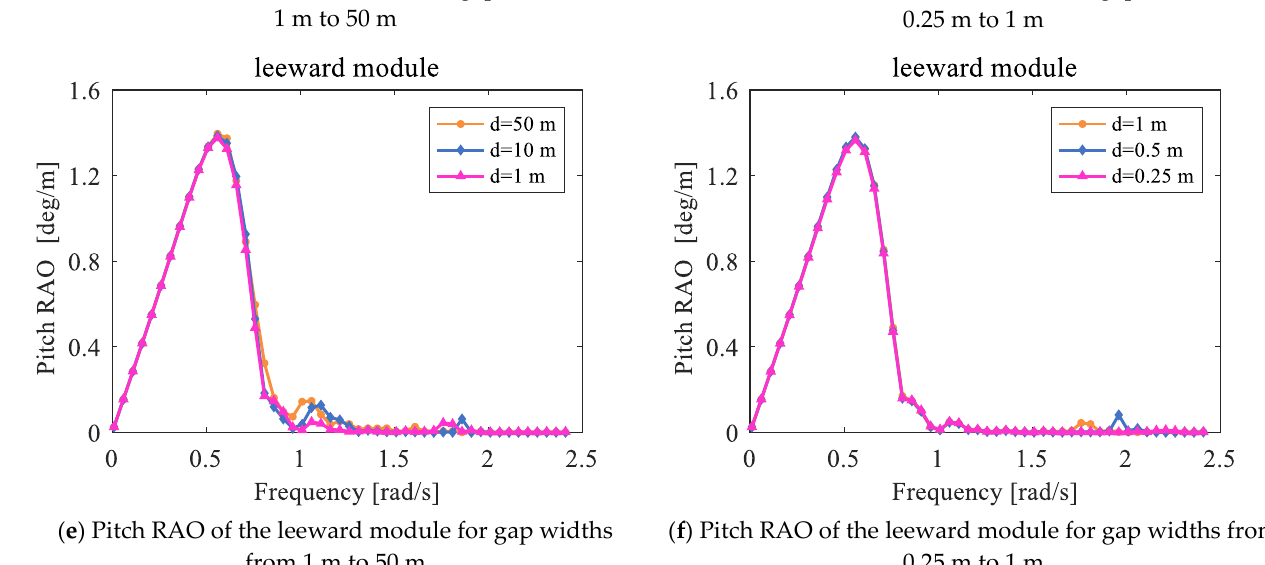
Rather than, for the hydrodynamic results, the effects of the gap width are stark. The